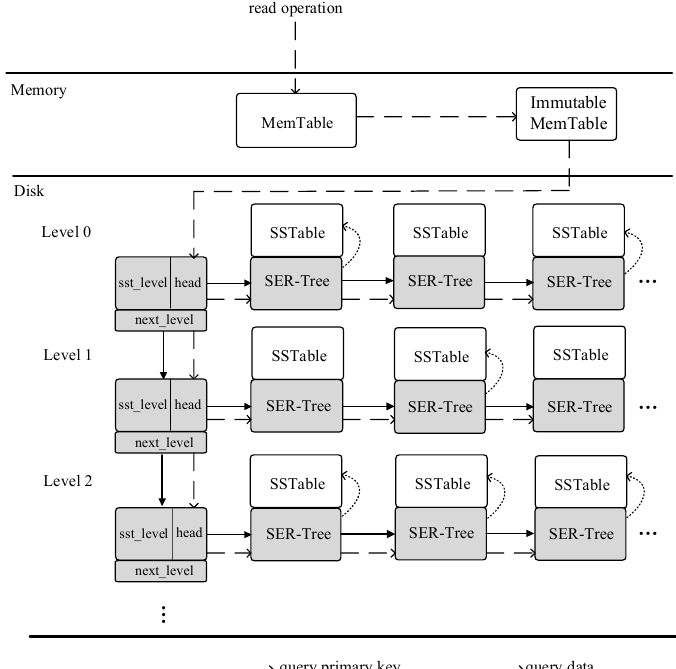
Figure 8. ER-tree index query flow.